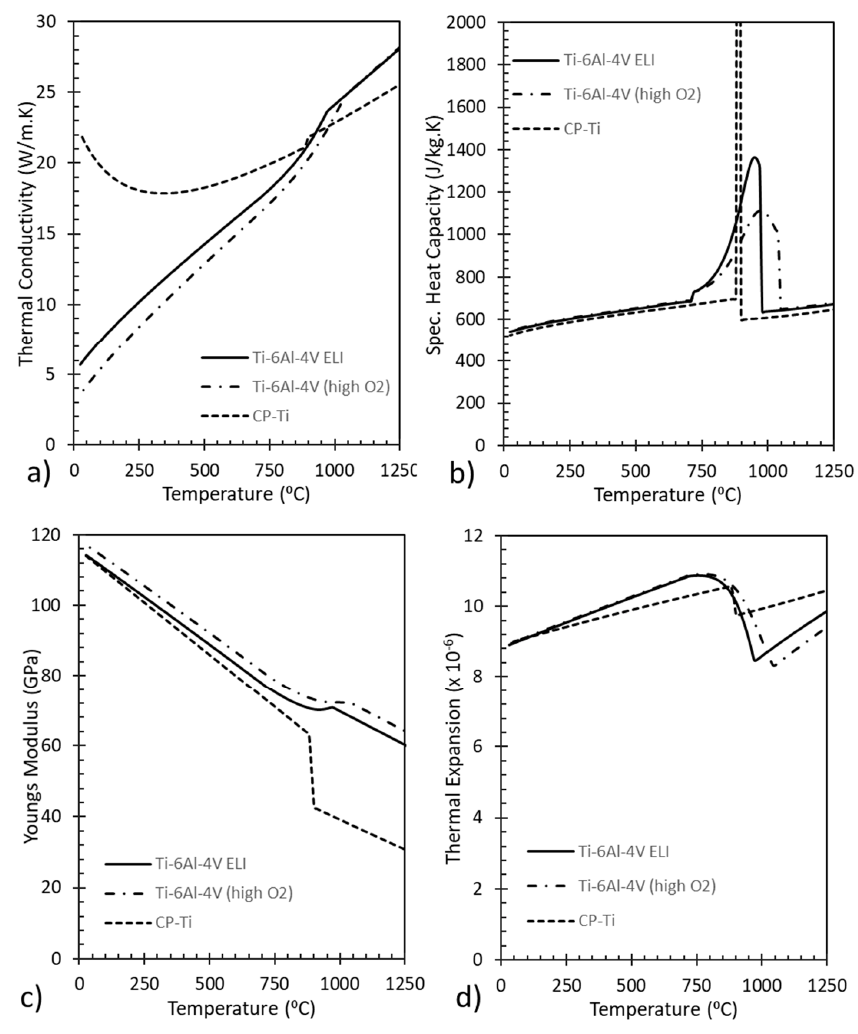
Figure 3. Temperature dependent thermo-physical properties; ( a ) Conductivity, ( b ) specific heat capacity, ( c ) Young’s modulus, ( d ) Thermal expansion; of Ti-6Al-4V (ELI), Ti-6Al-4V with higher O 2 pick-up, and commercially pure titanium (CP-Ti).